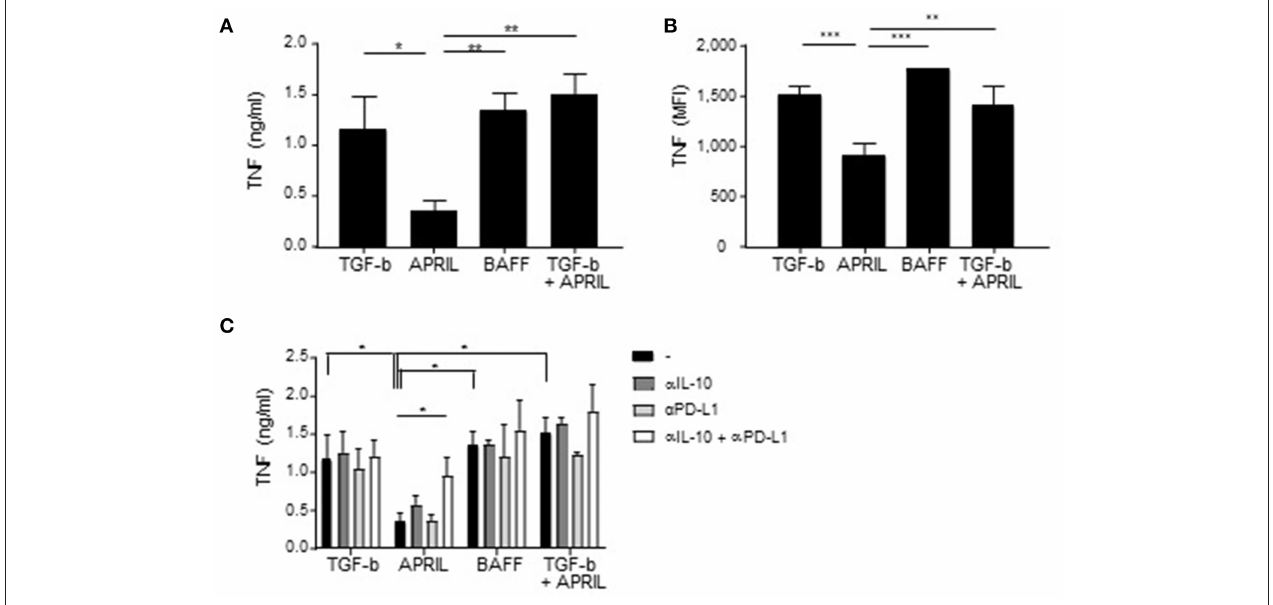
FIGURE 7 | APRIL-induced IgA + regulatory B cells suppress TNF production by GM-CSF macrophages. (A,B) TNF production by the macrophages upon co-culture with TGF- β -, APRIL-, BAFF- or TGF- β + APRIL-induced IgA + B cells is assessed using TNF ELISA (A) and intracellular TNF staining (B) . (C) Neutralizing antibodies to IL-10 and PD-L1 were added to the co-cultures. After 3 days of co-culture, supernatant was harvested and TNF was measured using ELISA. Mean ± SD are shown, n = 3. * P < 0.05, ** P < 0.01, and *** P < 0.001 (one- or two-way ANOVA with Bonferroni multiple comparison